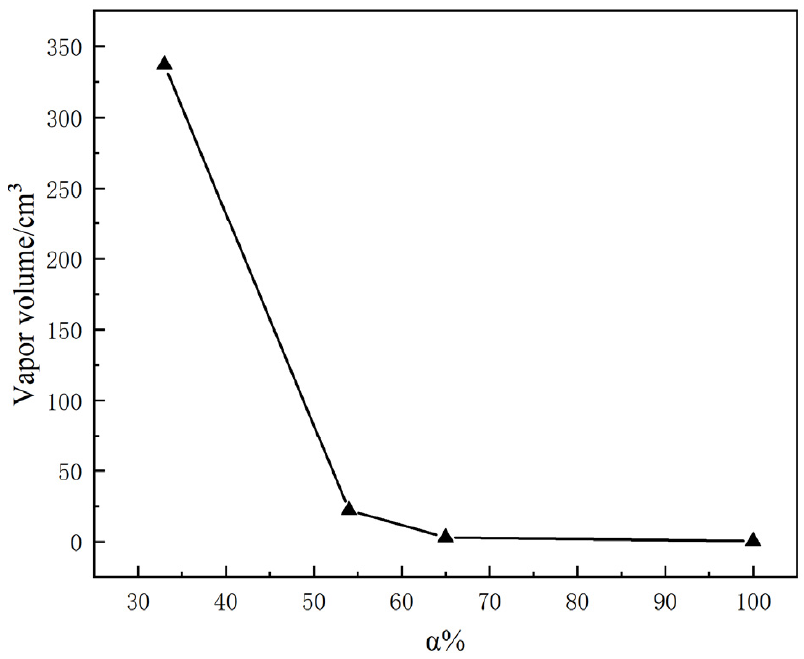
Figure 6. The vapor volume in the runner changes with the opening of the movable guide vane. A dynamic cycle from generation, to development, to partial collapse, to disappear- ance, to reformation can be observed in the cavitation inside the runner. Therefore, the changes of vapor volume in the runner followed certain rules. Figure 7 shows the seven cavitation transformation cycle times in the runner under part-load conditions and the spectral characteristics obtained through FFT (fast Fourier transform). Under these condi- tions, the rotating frequency of the runner was 22.5 Hz, and the domain frequency obtained by FFT accounted for 30% of the rotation frequency; that is, the conversion frequency of the cavitation in the runner can be considered as 30% of the rotation frequency.